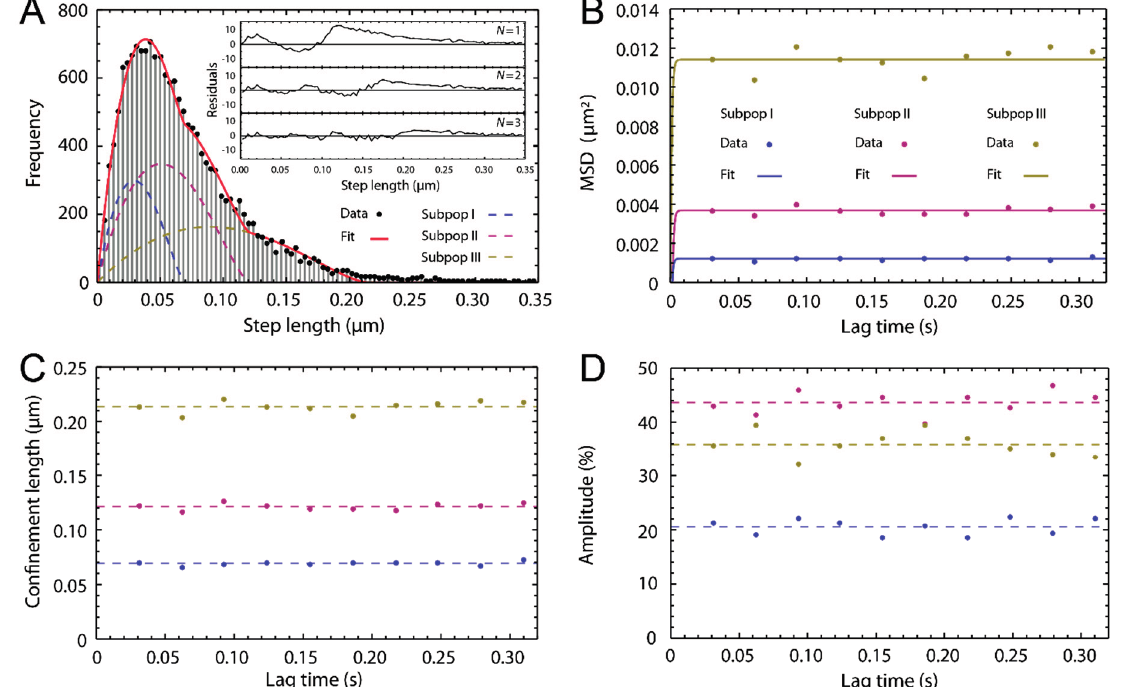
Figure 5. Single particle tracking (SPT) analysis. ( A ) Histogram of the step length distribution for the molecules found in the image presented in Figure 4G (frame lag = 1, t lag = 31 ms). The fit with Equation (1), yielding three subpopulations, is shown. The inset shows the residuals for fits with N = 1,2,3 subpopulations; ( B ) The mean square displacements (MSD)-lag-time plot of the three subpopulations with data points at ten different lag times and fit with Equation (4); ( C ) Corresponding confinement lengths. The average values are indicated by broken lines; ( D ) Amplitudes of the three subpopulations given in %. The average values are indicated by broken